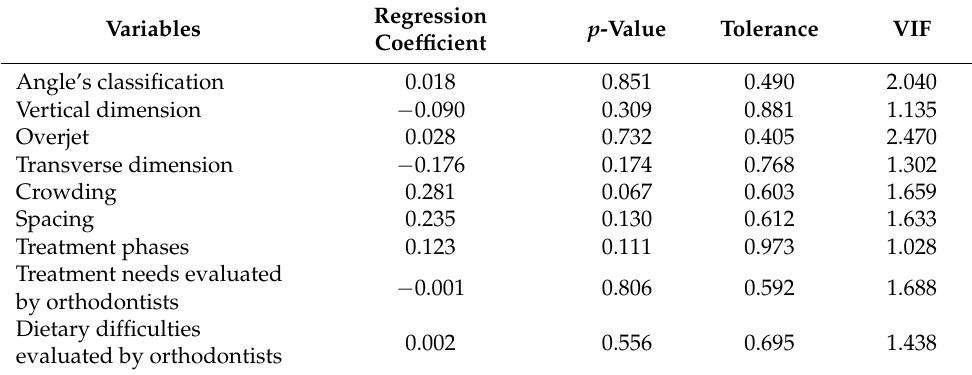
Table 7. Multiple regression analysis of influential factors on the self-perceived dietary difficulties of orthodontic